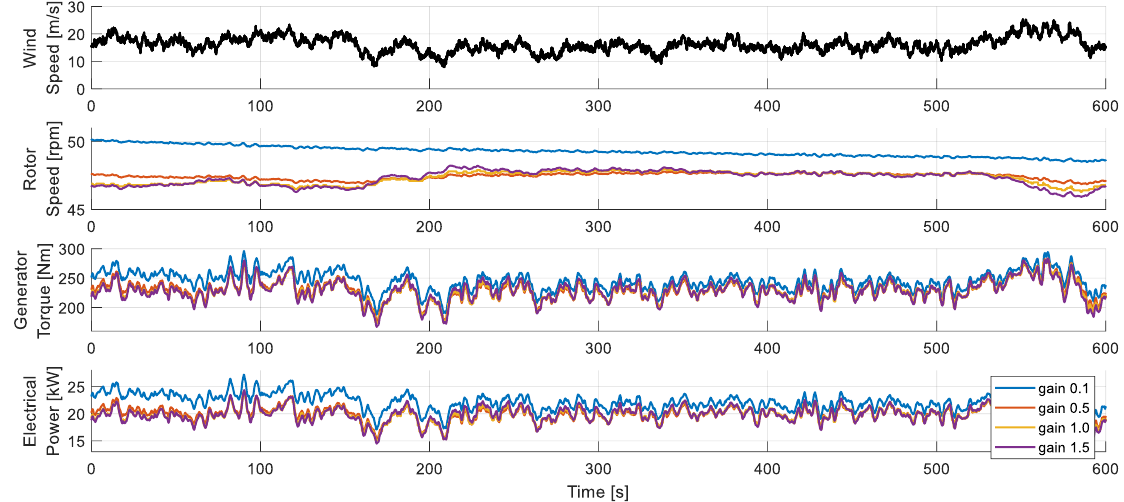
Figure 9. Dynamic simulation results of proposed stall control with a gain, 𝑘 𝑔 .